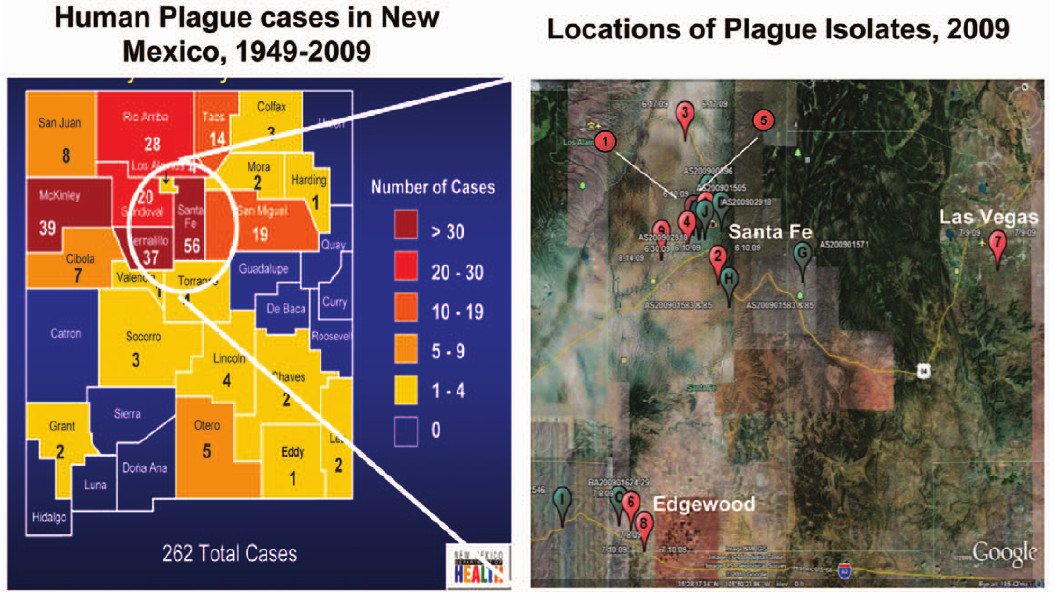
Figure 1. New Mexico is a Portion of the Enduring North American Plague Focus. Highly virulent Yersinia pestis can be found among numerous rodent and animal hosts, occasionally infecting humans and their pets when they come into contact with infected animals or fleas. Samples were chosen for sequencing to represent examples coming from each broad geographic region. Common hosts include squirrels, cats, prairie dogs ( Cynomys gunnissoni ) and rabbits ( Sylvilagus audubonii ) [3]. Sequenced isolates are shown with red markers; other cases with green markers (Location map on right). Locations of isolation of strains were mapped using Google Earth H . Source: New Mexico State Dept. of Public Health [32]. doi:10.1371/journal.pone.0031604.g001 PLoS ONE |